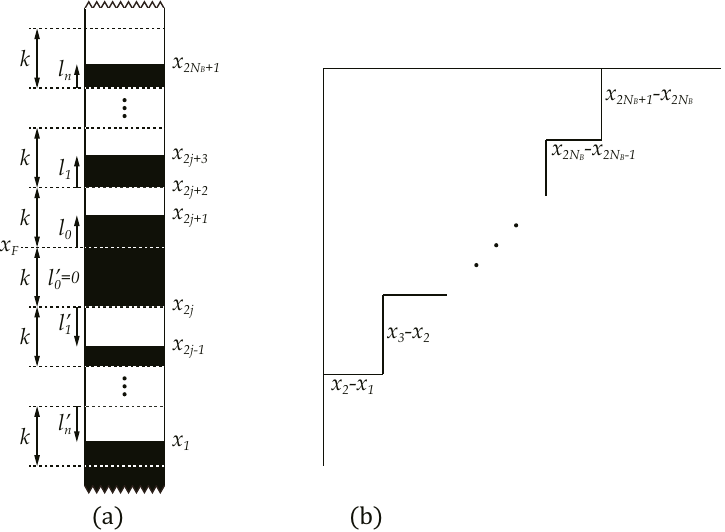
Figure 1 . (a) A droplet representation of the LLM geometry with SO(2 ; 1) (cid:2) SO(4) = Z k (cid:2) SO(4) = Z k isometry. The horizontal width does not correspond to any coordinate but added for clarity. (b) The Young diagram corresponding to the droplet picture